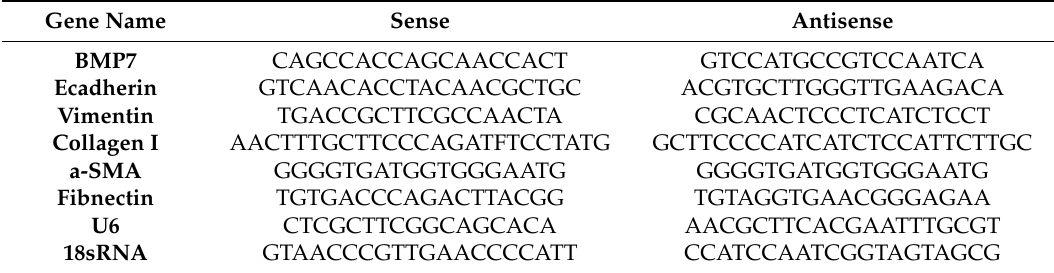
Table 1. The sequences of the primers for real-time